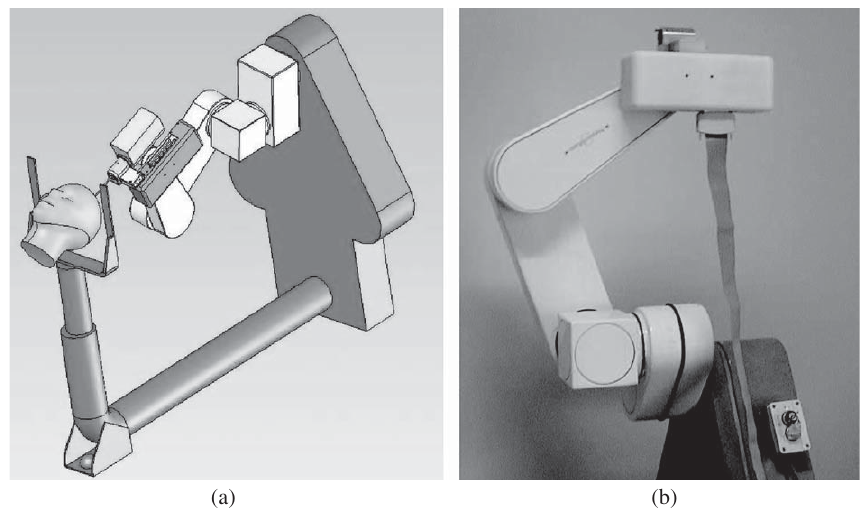
Fig. 7. DAANS’ slave actuator and Neuromate ® . a) Treatment by DAANS and Neuromate. b) Slave module and Neuromate arm at the Neurosurgical Department, University of Florence,